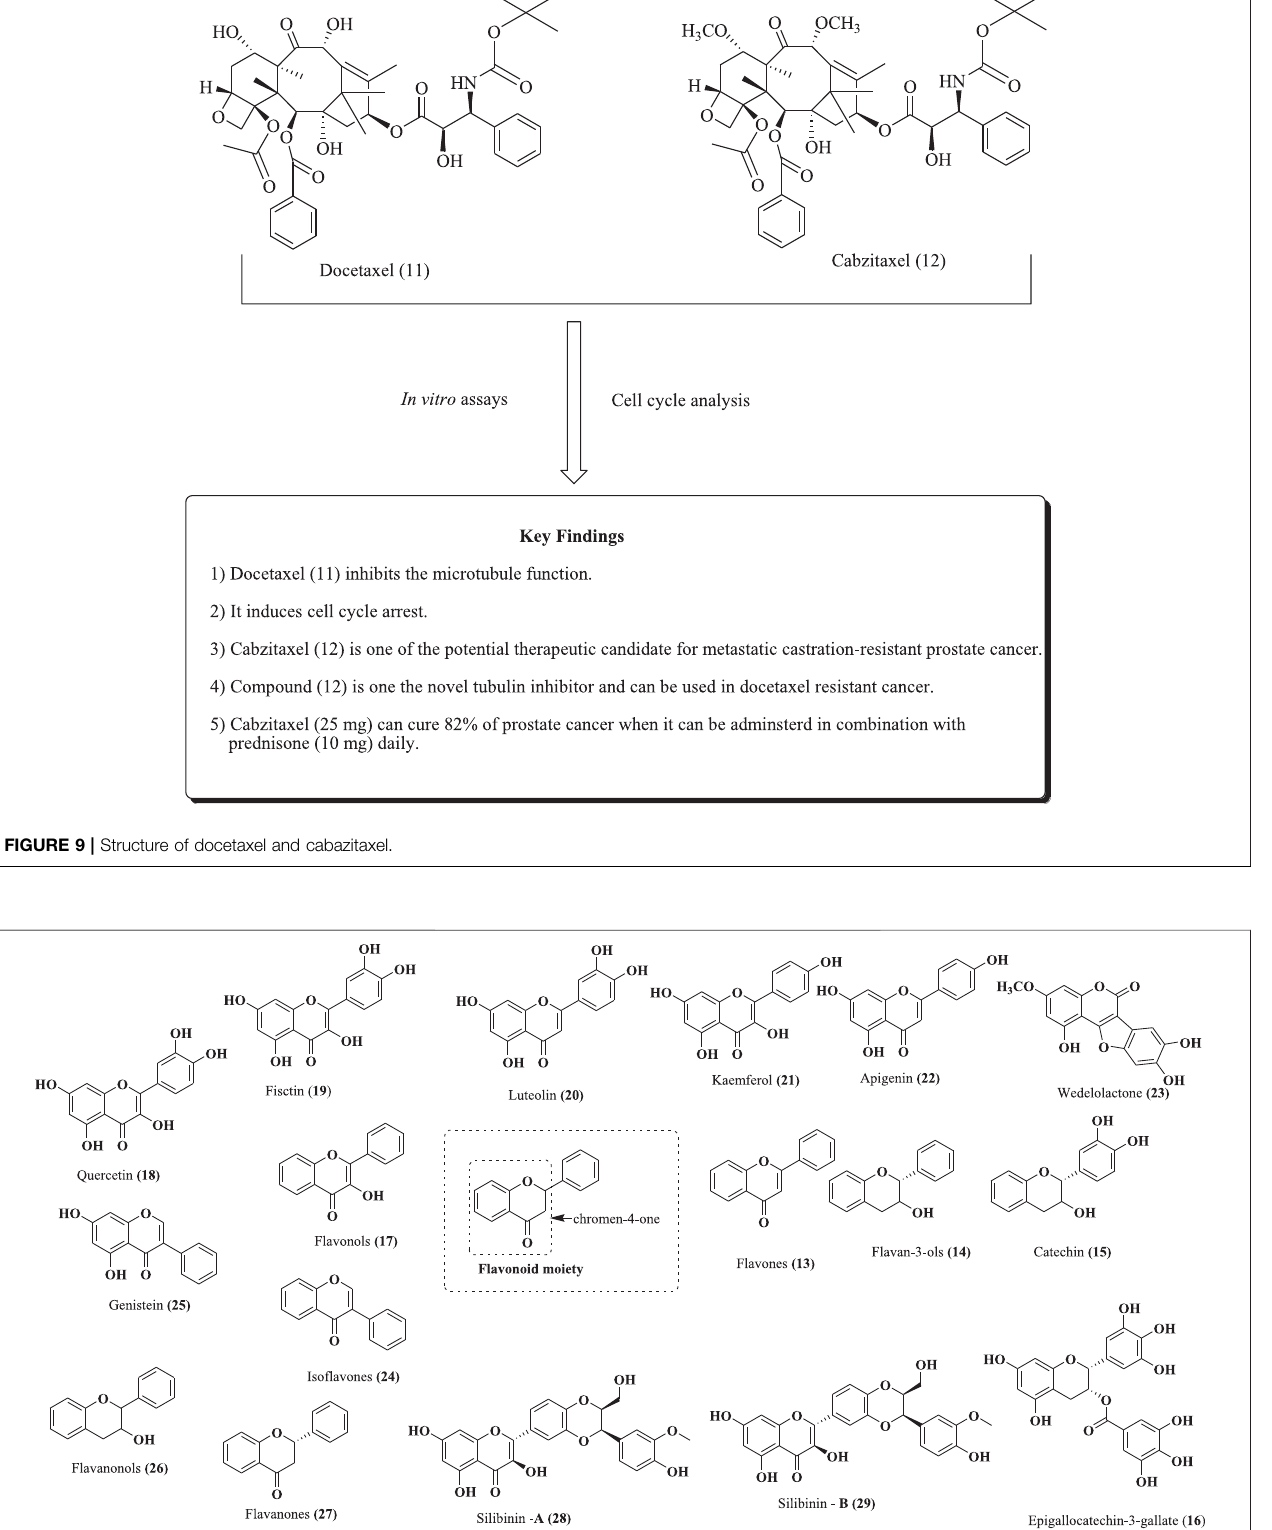
FIGURE 10 | Structures of fl avonoid-based phytochemicals (13 – 29).